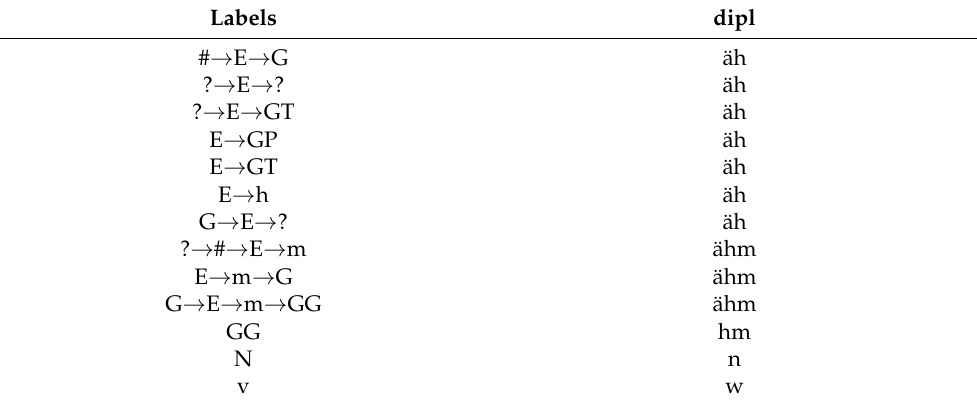
Table 4. Segment sequences for vocalic filler particles with n = 2.